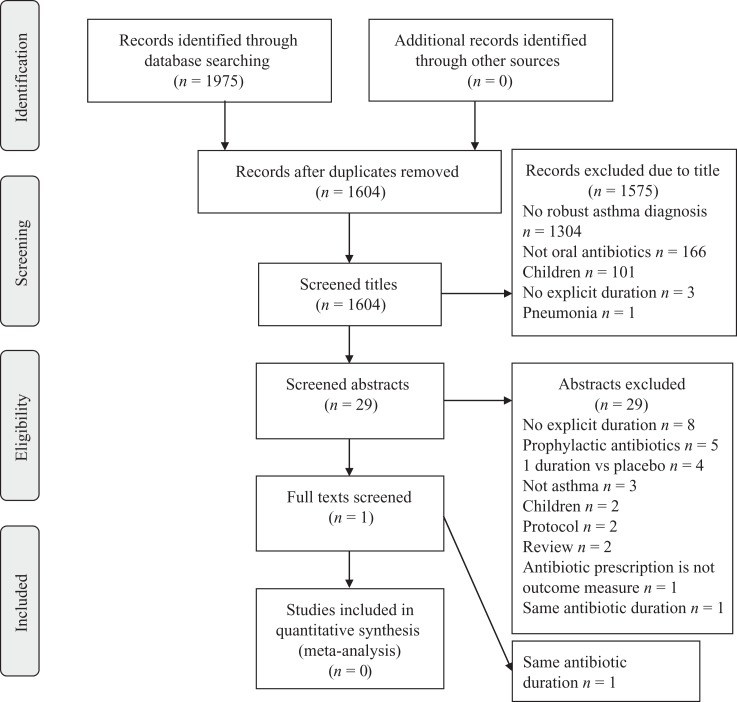
PRISMA flow diagram of systematic search for asthma studies.